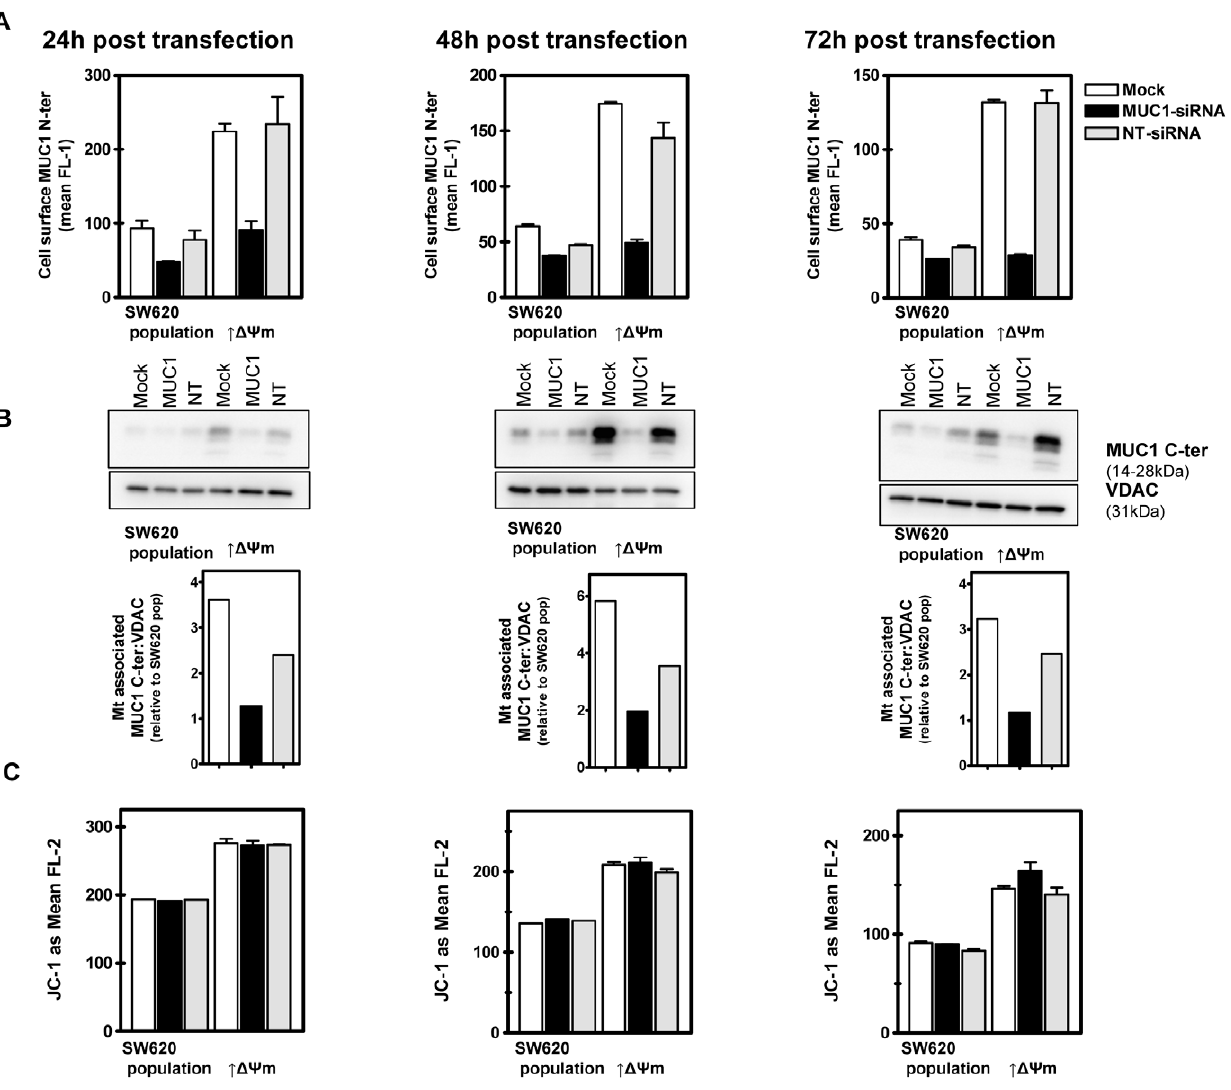
Figure 4. siRNA-mediated down regulation of MUC1 N-ter and mt-associated C-ter levels does not affect the Dy m. Cells were mock, MUC1- or NT-siRNA transfected. Twenty-four, 48 and 72 hours later, levels of cell surface MUC1 N-ter were determined by flow cytometry ( A ); levels of mt-associated MUC1 C-ter determined by quantitative immunoblotting ( B ) and the Dy m was determined by JC-1 staining and flow cytometry.